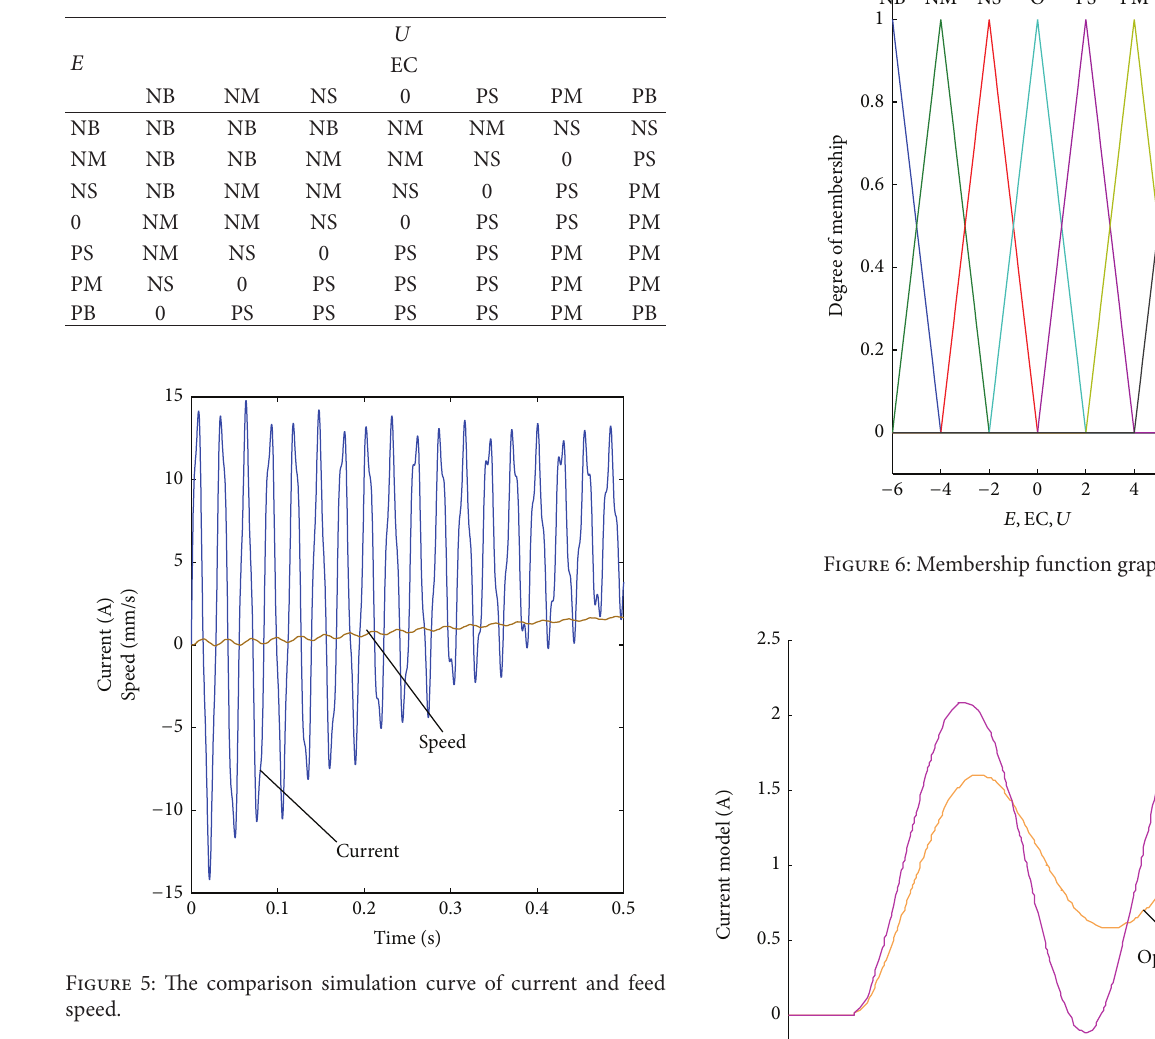
Table 4: The dynamic characteristic-based control rules.